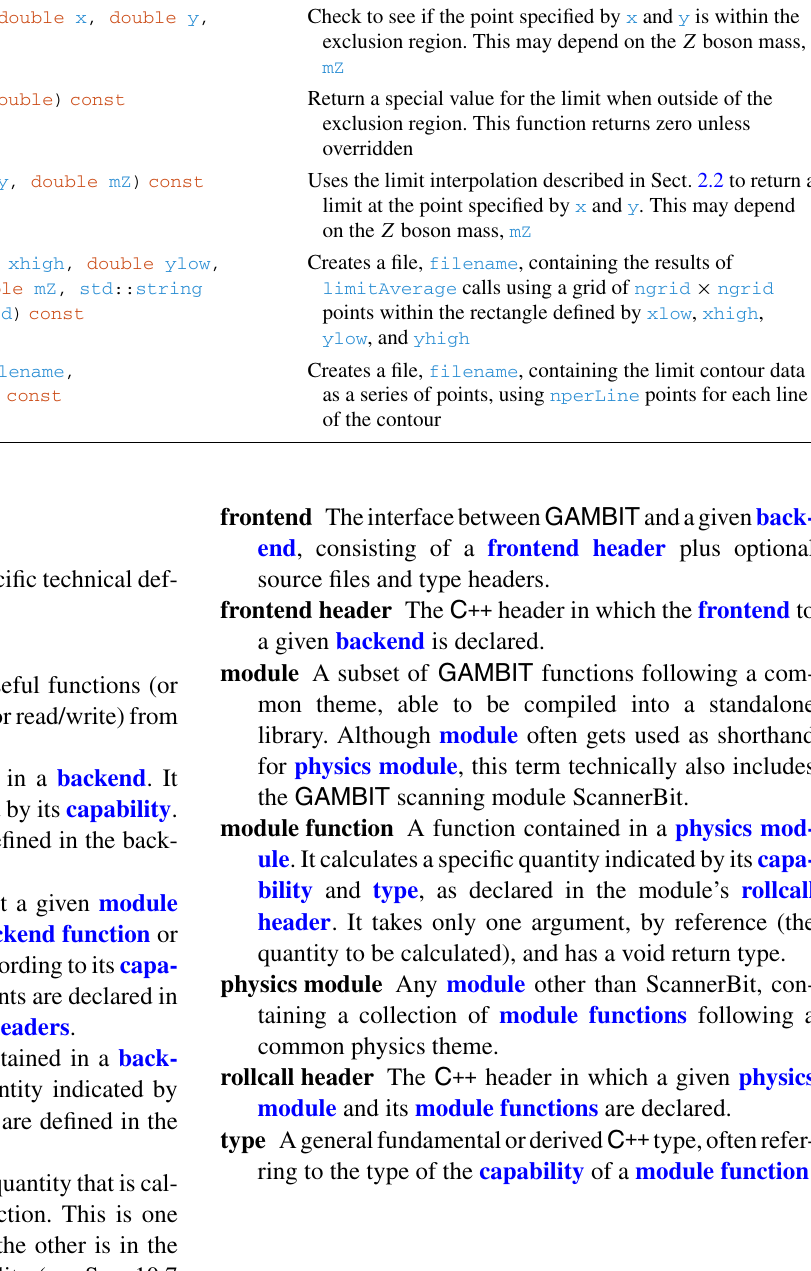
to be overridden. Note that P2 is a simple class that represents a point found on the limit plane and is defined in the header file